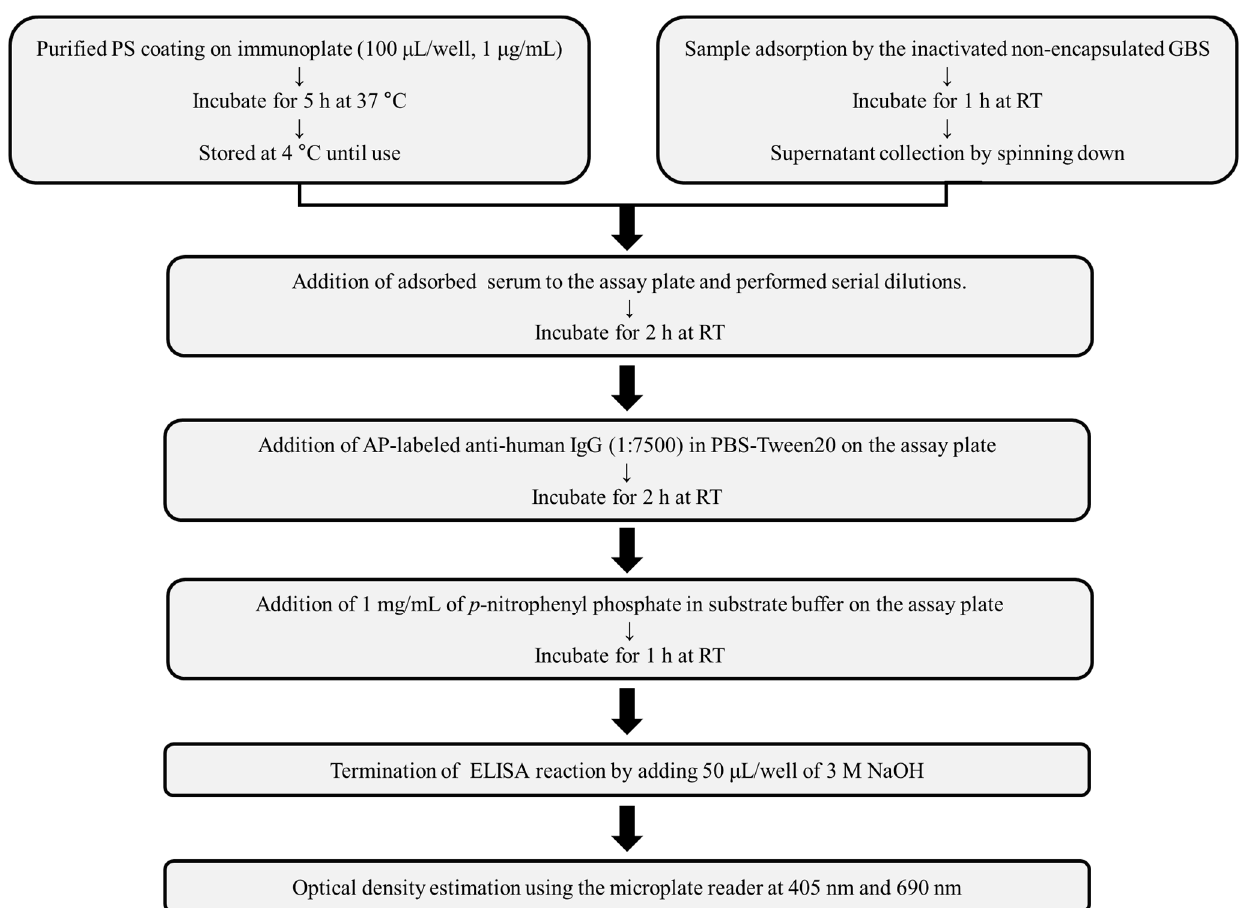
Figure 2. Schematic overview of enzyme-linked immunosorbent assay (ELISA) to measure group B Streptococcus (GBS) polysaccharide (PS)-specific IgG. To reduce non-specific binding, samples were reacted with inactivated non-encapsulated GBS before ELISA. Subsequent steps were performed according to the pneumococcal ELISA protocol. PS, polysaccharide; RT, room temperature; AP, alkaline phosphatase. Table 2. Correlation (coefficient of determination [r 2 ]) between dilution factors and absorbance (optical density, OD) according to polysaccharide (PS) coating